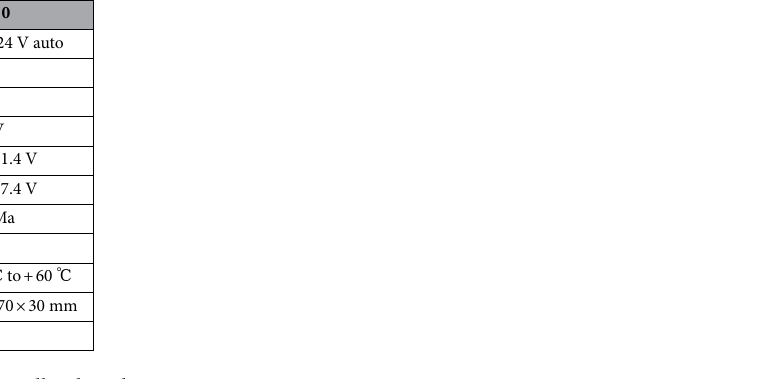
Table 2. Solar charging controller data